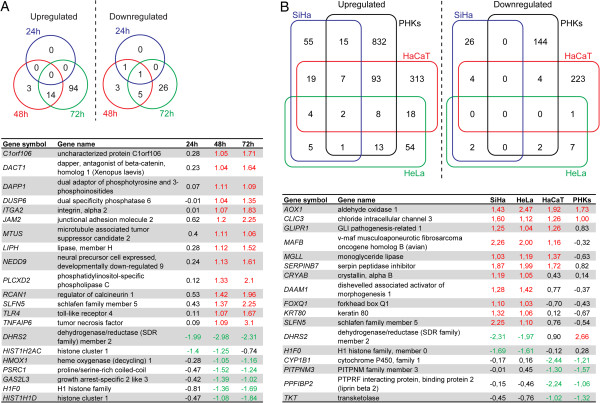
Venn diagram representation of differentially expressed genes in the microarray experiments. (A) Venn diagram analysis identifying the common and exclusively DE genes in SiHa cells treated with CDV for 24 h, 48 h, and 72 h and table listing the genes that were DE (log2 fold) at 24 h or 48 and 72 h post-treatment. (B) Venn diagram analysis of DE genes among the four cell types following treatment with CDV for 72 h and table listing the genes that were only up- or downregulated (log2 fold) in all four cell types, only in HPV+ cells, or only in HPV- cells.